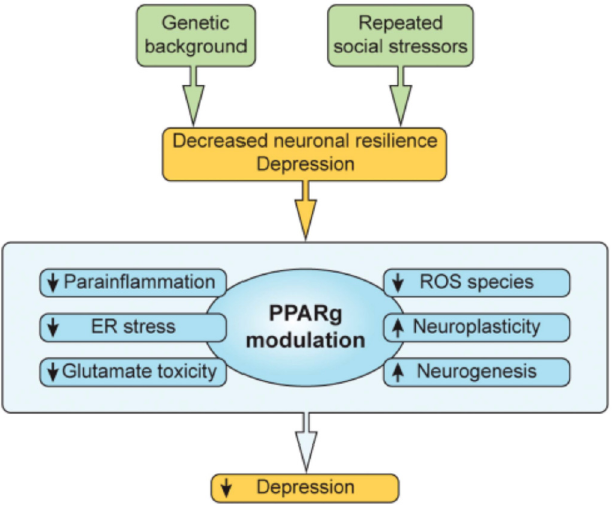
Figure 4. Repeated social and other stressors plus genetic predisposition lead to decreased neuronal resilience that can, in turn, lead to depression. Processes set into motion include parainflammation, extreme endoplasmic reticulum stress responses, glutamate toxicity, BDNF function, and the regulation of central and peripheral insulin dynamics. The PPARg system can modulate and diminish each of these pathologic drivers, and others as well, as noted in the text.